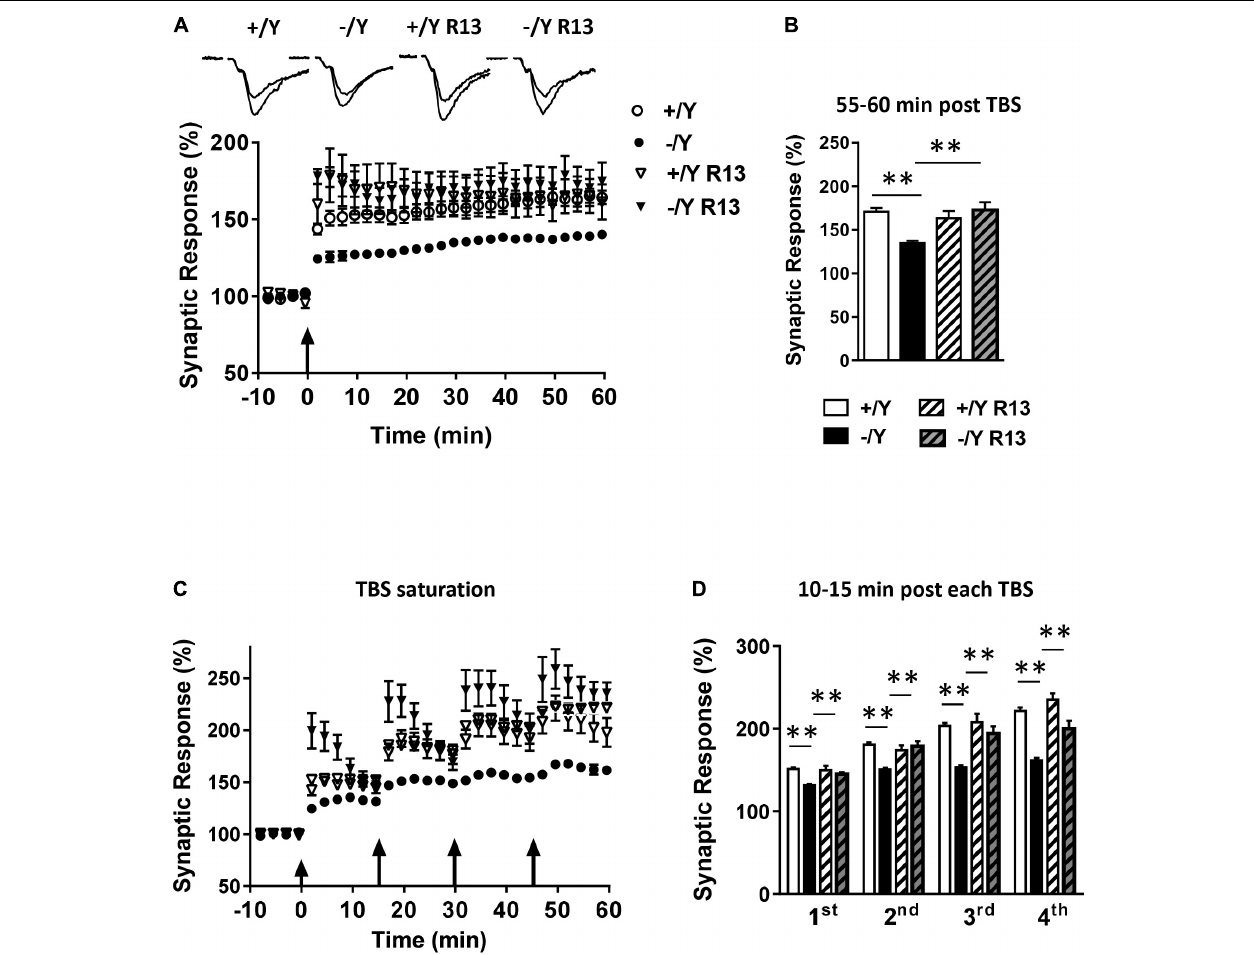
FIGURE 5 | Effect of treatment with R13 on LTP in the perirhinal cortex of Cdkl5 − /Y mice. (A) Amplitude of the synaptic responses evoked before and after TBS. Here, and in the following panels (B–D) , the amplitude of the responses is expressed as a percentage of the average amplitude of responses recorded 10 min before TBS. The traces at the top are examples of responses recorded before, and 55–60 min after, TBS. Here, and in panel C, the arrows indicate the time of TBS delivery. Recordings were carried out in slices from P50 vehicle-treated Cdkl5 + /Y ( n = 13; 7 animals) and Cdkl5 − /Y ( n = 13; 6 animals), and R13-treated Cdkl5 + /Y ( n = 6; 4 animals) and Cdkl5 − /Y ( n = 7; 7 animals) mice. (B) The histograms indicate the averaged amplitude of the responses recorded 55–60 min after TBS. Same data as in (A) . (C) Amplitude of the synaptic responses evoked before and after four consecutive TBS stimulations delivered at 15-min intervals. Recordings were carried out in slices from P50 vehicle-treated Cdkl5 + /Y ( n = 6; 6 animals) and Cdkl5 − /Y ( n = 7; 7 animals), and R13-treated Cdkl5 + /Y ( n = 7; 4 animals) and Cdkl5 − /Y ( n = 6; 6 animals) mice. (D) The histograms indicate the averaged amplitude of the responses recorded 10–15 min after each TBS. Same data as in (C) . Values represent mean ± SE. ∗ p < 0.05; ∗∗ p < 0.01 (Tukey test after two-way ANOVA).